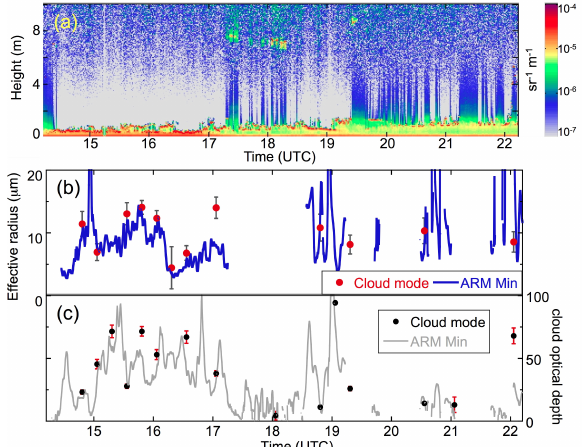
Fig. 10. (a) Attenuated backscatter signal from micropulse lidar Fig. 10 . (a) Attenuated backscatter signal from micropulse lidar on 15th June 2007. A time 3 on 15 June 2007. A time series of effective radius (b) and cloud series of effective radius (b) and cloud optical depth (c) from cloud-mode measurements and 4 optical depth (c) from cloud-mode measurements and the ARM Min the ARM Min dataset. The error bars represent one standard deviation. In (b) , we omit the 5 dataset. The error bars represent one standard deviation. In (b) , we default values of 8 µm reported in the ARM Min retrievals. In (c) , cloud optical depth from 6 omit the default values of 8µm reported in the ARM Min retrievals. the ARM Min dataset was truncated at 100 for plotting purposes. 7 In (c) , cloud optical depth from the ARM Min dataset was truncated at 100 for plotting